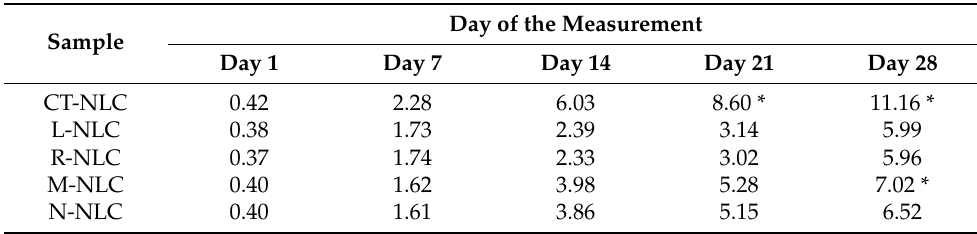
Table 2. Turbiscan Stability Index (TSI) of NLC analyzed for 30 days at 25 ◦ C using Turbiscan ® Aging Station. * Significance for p <